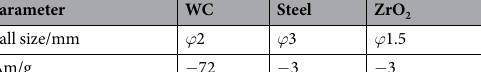
Parameter WC Steel ZrO 2